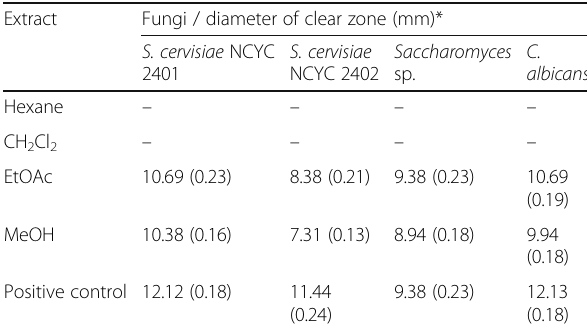
Fig. 10 TLC profiles of ( a ) hexane extract (eluent: 20% CH 2 Cl 2 in hexanes) and ( b ) CH 2 Cl 2 extract (eluent: CH 2 Cl 2 ) of F. racemosa